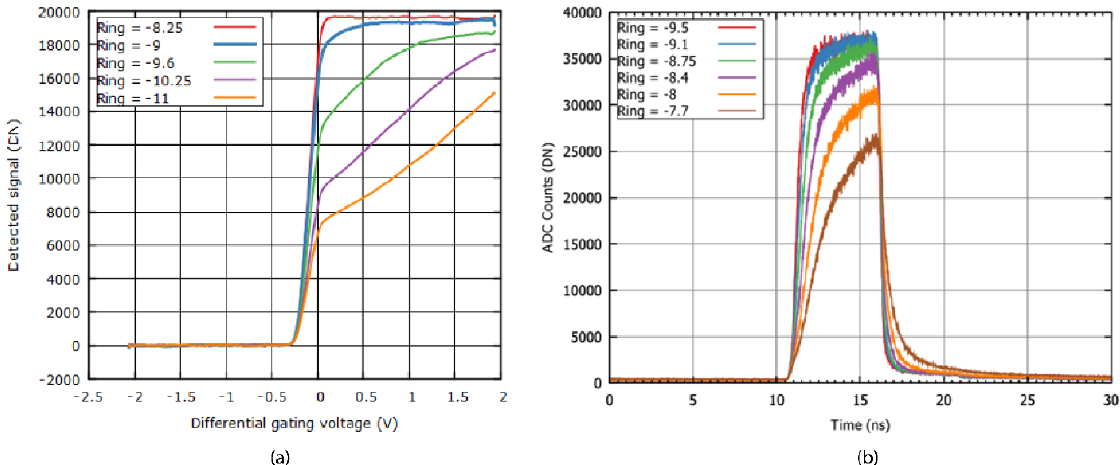
Figure 16. Gating behavior of the CAPS sensor in DC ( a ) and instrument response function (IRF) for a 4 ns gate ( b ).